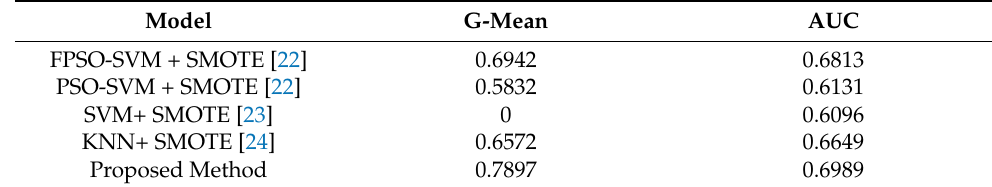
Table 3. Comparison of G-mean and AUC values for different models on the Haberman dataset. Model